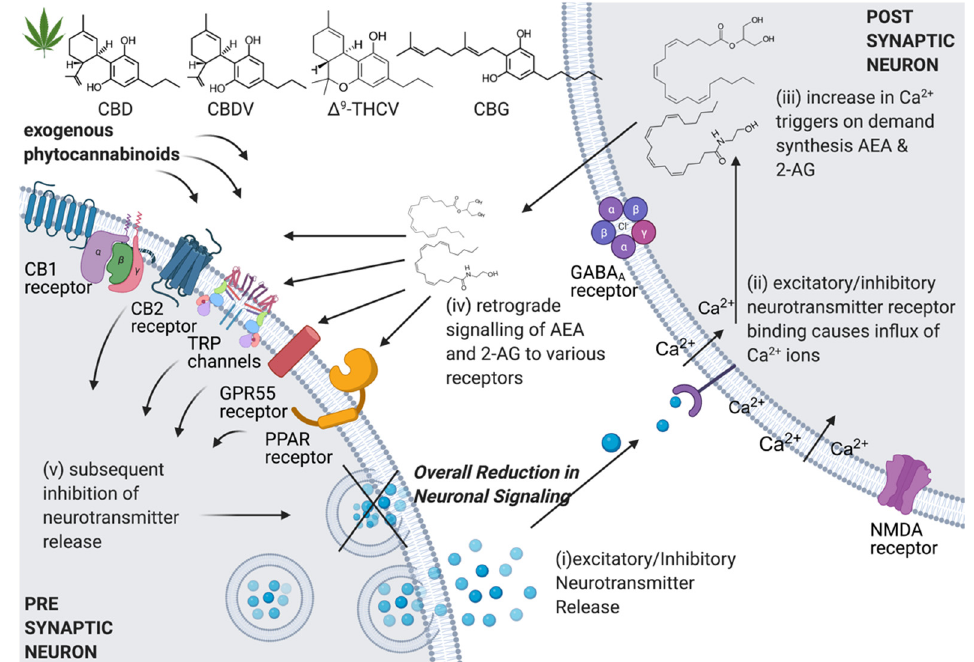
Figure 2. Synaptic transmission of the ECS: ( i ) Excitatory/inhibitory neurotransmitter release into the synapse ( ii ) Neurotransmitter binding to post-synaptic neuron ( iii ) Depolarisation causes an influx of calcium ions that initiates on-demand synthesis and release of endocannabinoids ( iv ) Binding of endocannabinoids to various pre-synaptic receptors leads to subsequent modulations in neurotransmitter release ( v ) Inhibition of further synaptic communication reduces seizure activity downstream.